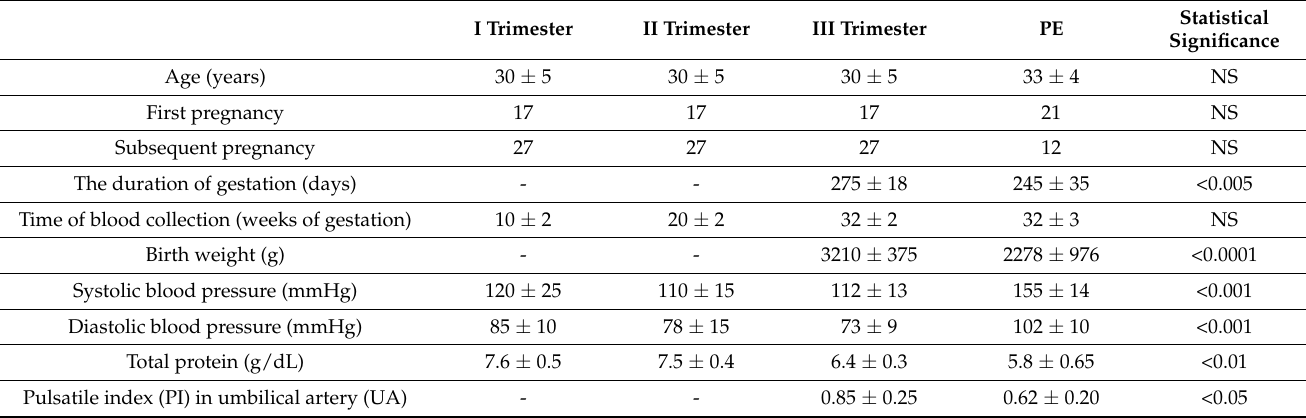
Table 1. The clinical and laboratory characteristics of pregnant patients with PE (n = 35) and women in normal pregnancy (n =